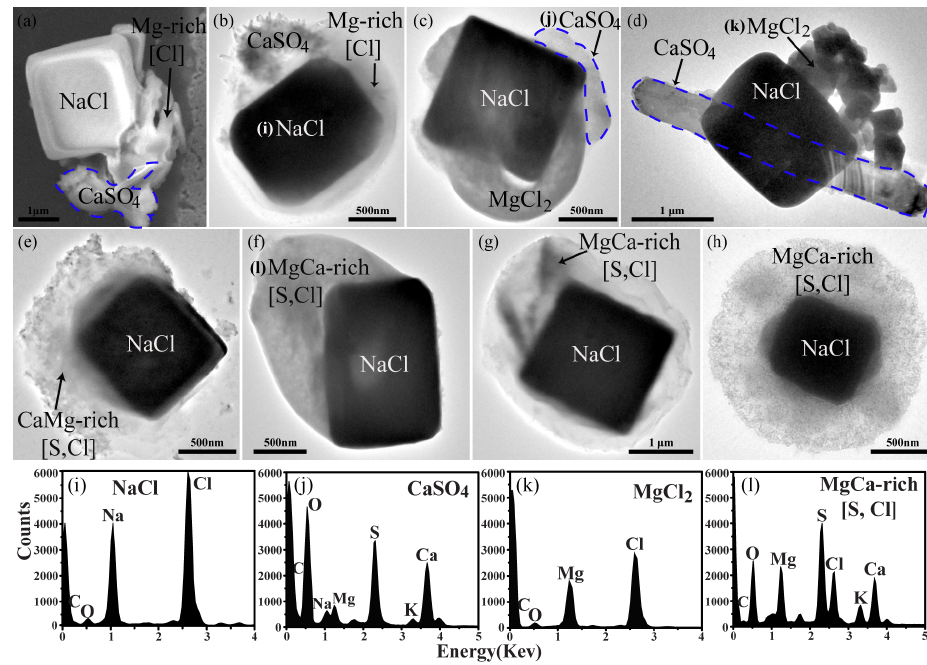
Figure 2. Morphology and EDX spectra of the typical fresh SSA. (a) One SEM image, (b–h) TEM images, and (i–l) EDX spectra of NaCl, MgCl 2 , CaSO 4 , and MgCa-rich. The main anionic elements are shown in the square